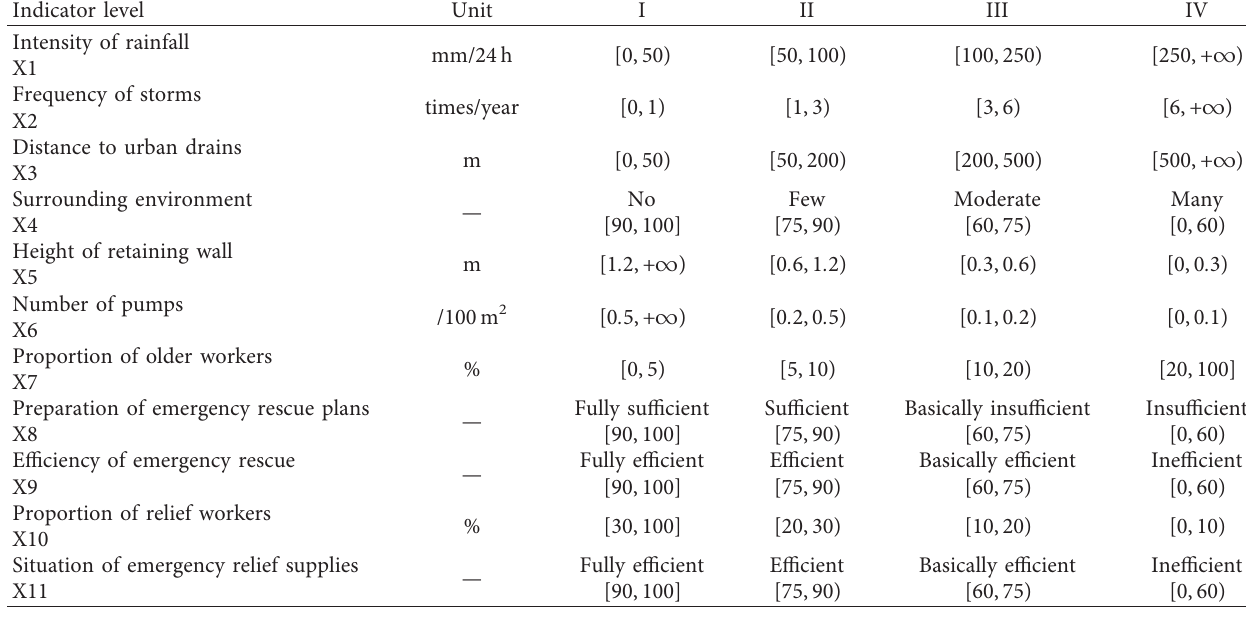
Table 1: The index system of waterlogging risk in the deep foundation pit